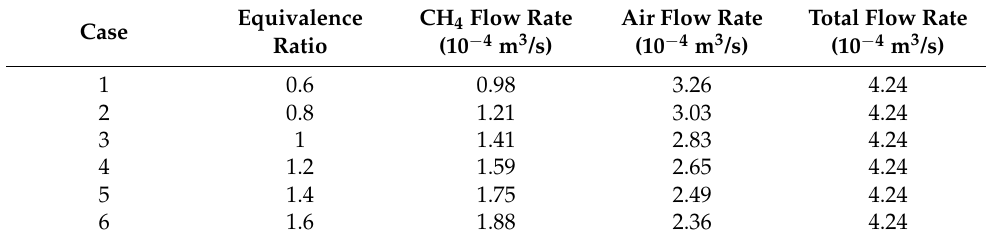
Table 1. CH 4 and air flow rates at different equivalence